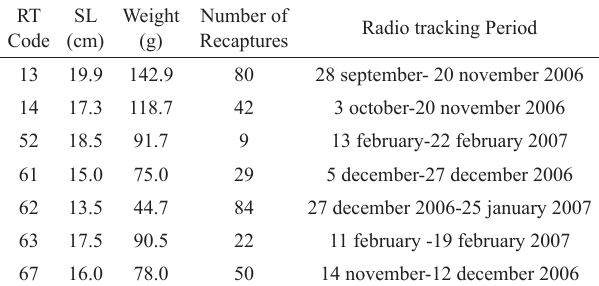
Tab. 1. Body size (weight and SL), number of recaptures (radio signal records) and radio tracking period for 7 individuals of Diplomystes camposensis . RT code: Specific radio transmitter code. SL: Standard